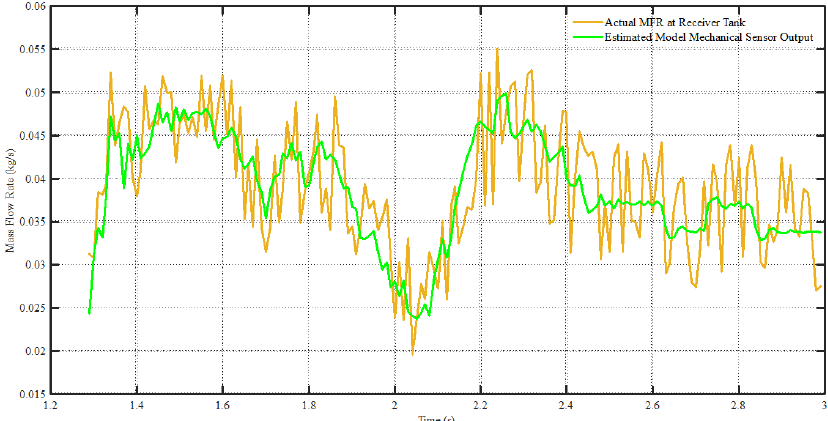
Figure 20. Actual MFR as a function of the MFR mechanical sensor.